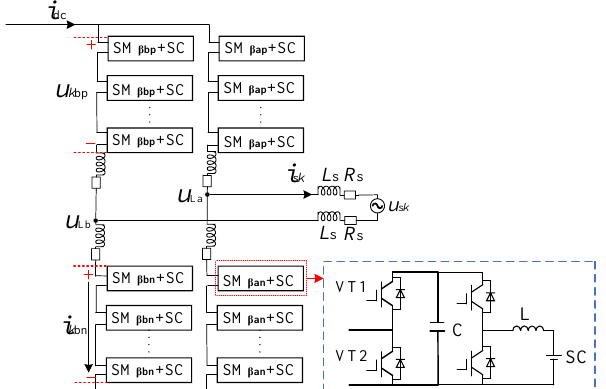
Figure 14. MMC-RPC scheme based on distributed super capacitor energy storage.